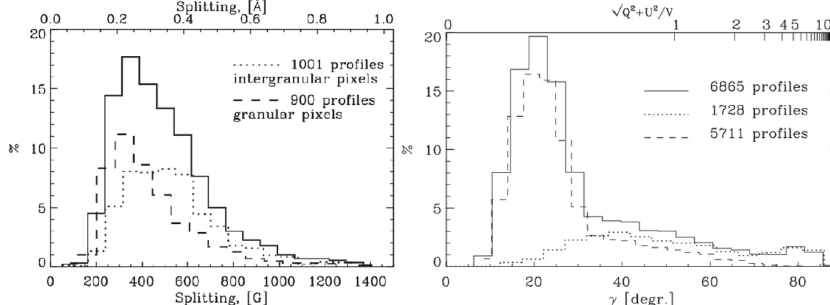
Fig.28 Left: Distribution of field strengths calculated from the Zeeman splitting of the Fe i lines at 1564.8 and 1565.2 nm. The solid, dashed, and dotted lines represent all pixels in the FOV, only granules, and only intergranular lanes, respectively. Right: Histogram of the field inclinations derived by comparing the Stokes Q and U amplitudes with the Stokes V amplitudes. The solid line represents all pixels. The dashed (dotted) line stands for the pixels with Stokes V (Stokes Q or U ) signals above the noise level. The right part of the field strength distribution corresponding to all pixels is well represented by an exponential of the form A exp ( − B / B 0 ) , with B 0 = 200 G and A a normalization constant. Image reproduced with permission from Khomenko et al. (2003), copyright by